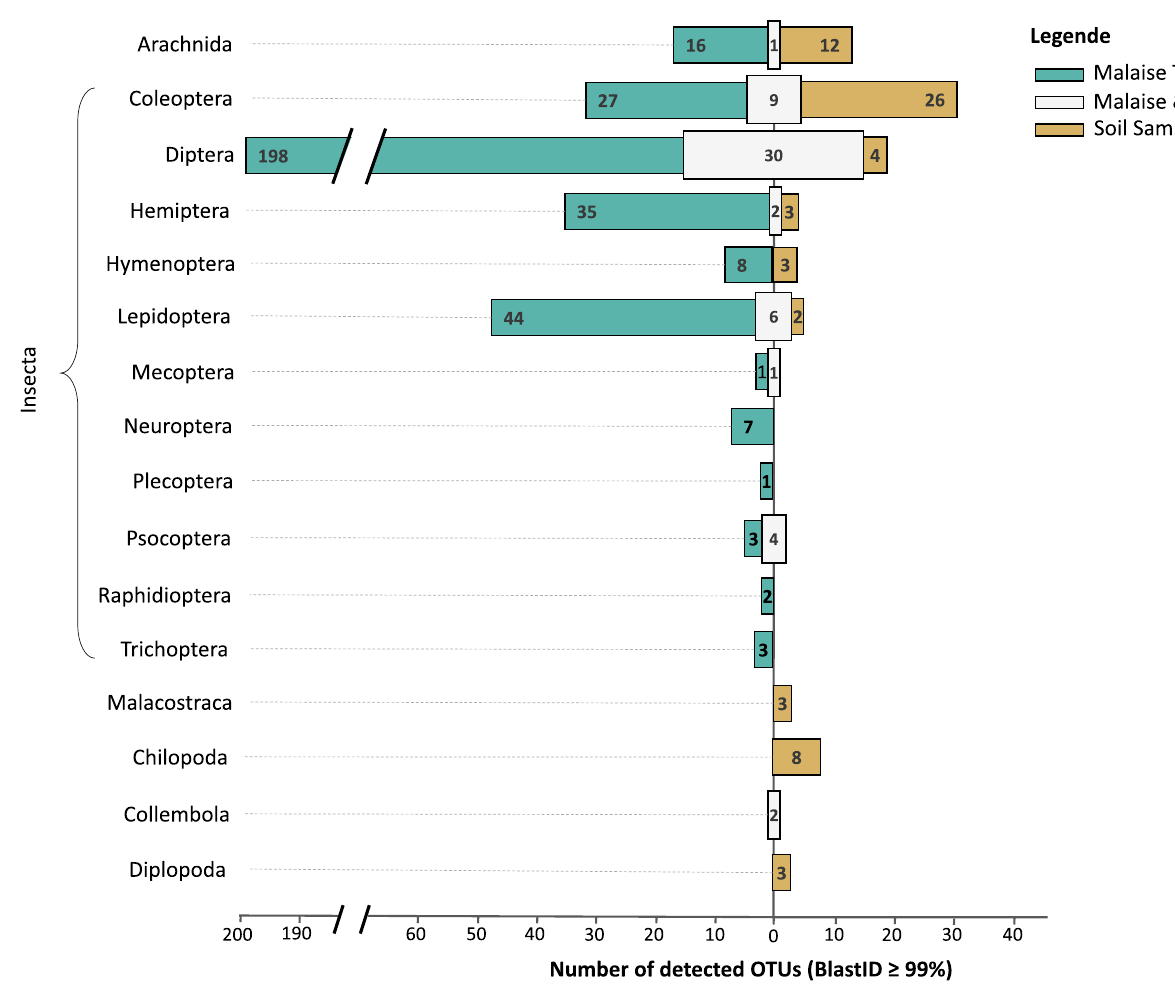
Figure 1. Number of unique and shared species (BlastID ≥ 99%) between Malaise traps and soil samples for the various arthropod classes found. For the class Insecta the number of shared and unique species per order is